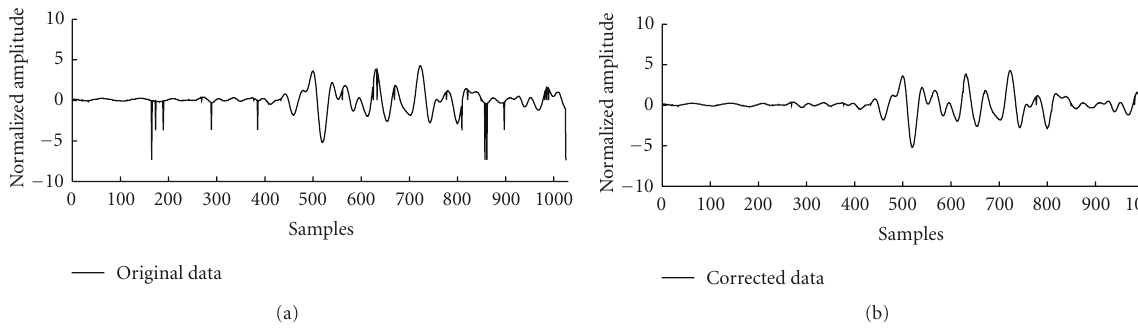
Figure 3: Original signal on (a) corrupted with spikes. At (b), the corrected signal with a median